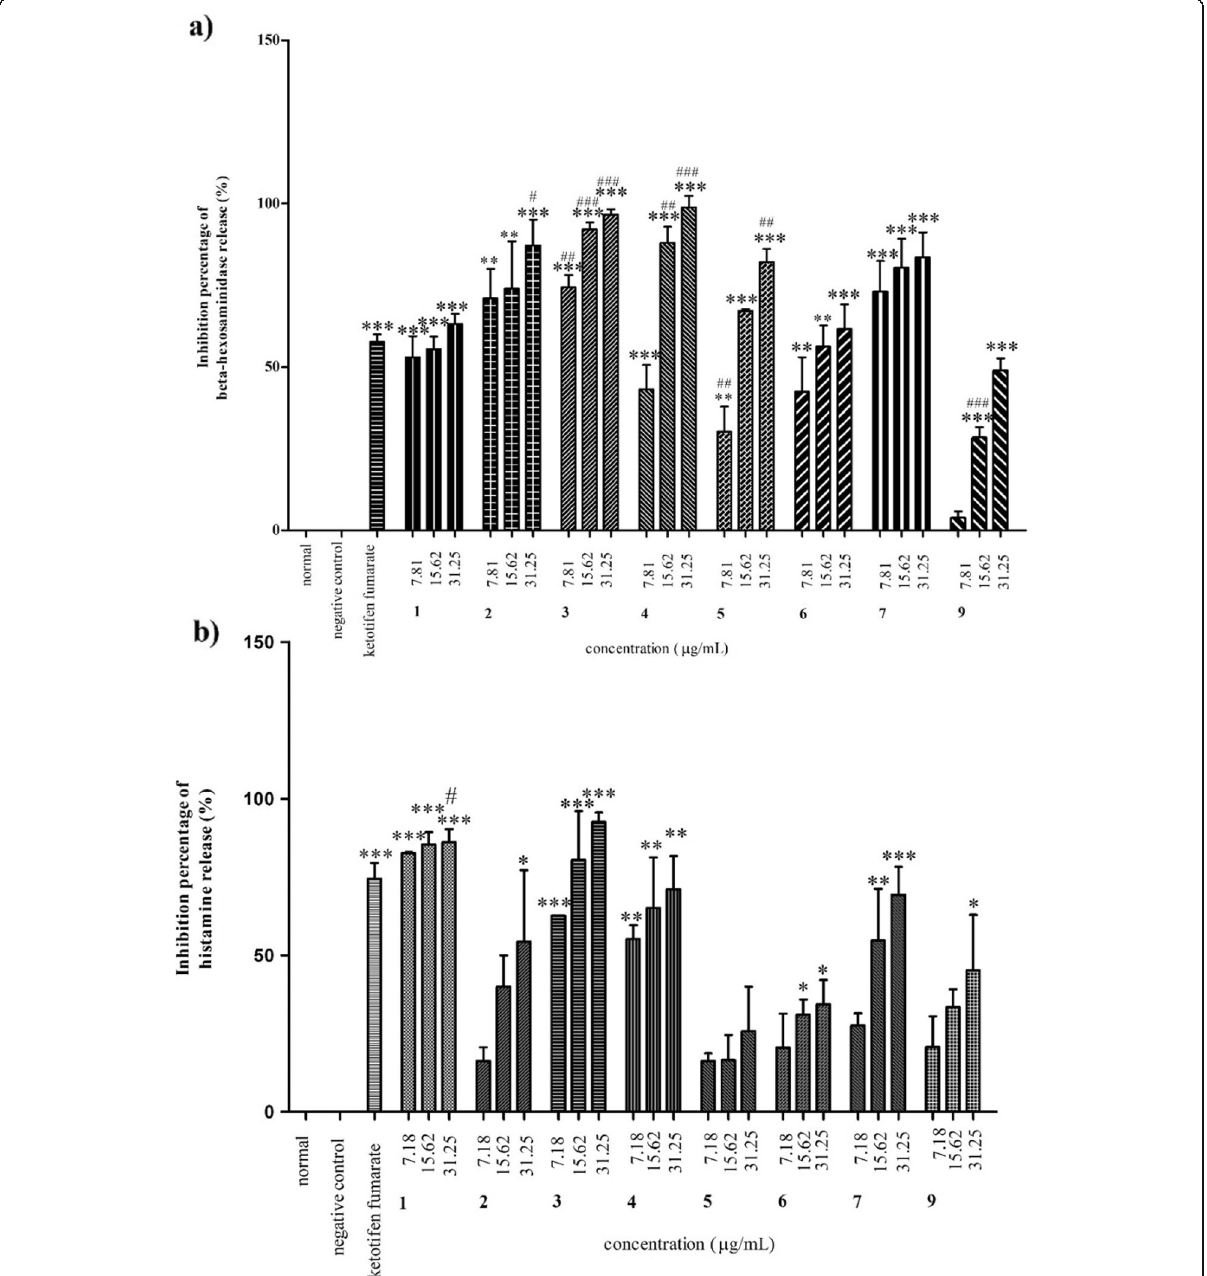
Fig. 4 Percentage inhibition of M. oleifera test compounds on a ) beta-hexosaminidase and b ) histamine releases. Data are presented as mean ± SEM (n = 3) with significant value of *p < 0.05, **p < 0.01, ***p < 0.001 as compared to positive control and and # p < 0.05, ## p < 0.01, ### p < 0.001 as compared to ketotifen fumarate. Ethyl-( E )-undec-6-enoate (1), 3,5,6-trihydroxy-2-(2,3,4,5,6-pentahydroxyphenyl)-4 H -chromen-4-one (2), Quercetin (3), Kaempferol (4), β -sitosterol-3- O -glucoside (5), Oleic acid (6), Glucomoringin (7), Stigmasterol O -glucoside ( 5 ) (IC : 7.33 ± 1.76 μ M) and glucomoringin 50 ( 7 ) (IC : 7.59 ± 0.39 μ M) showed the most comparable in- 50 hibitory activity to ketotifen fumarate (IC : 7.24 ± 50